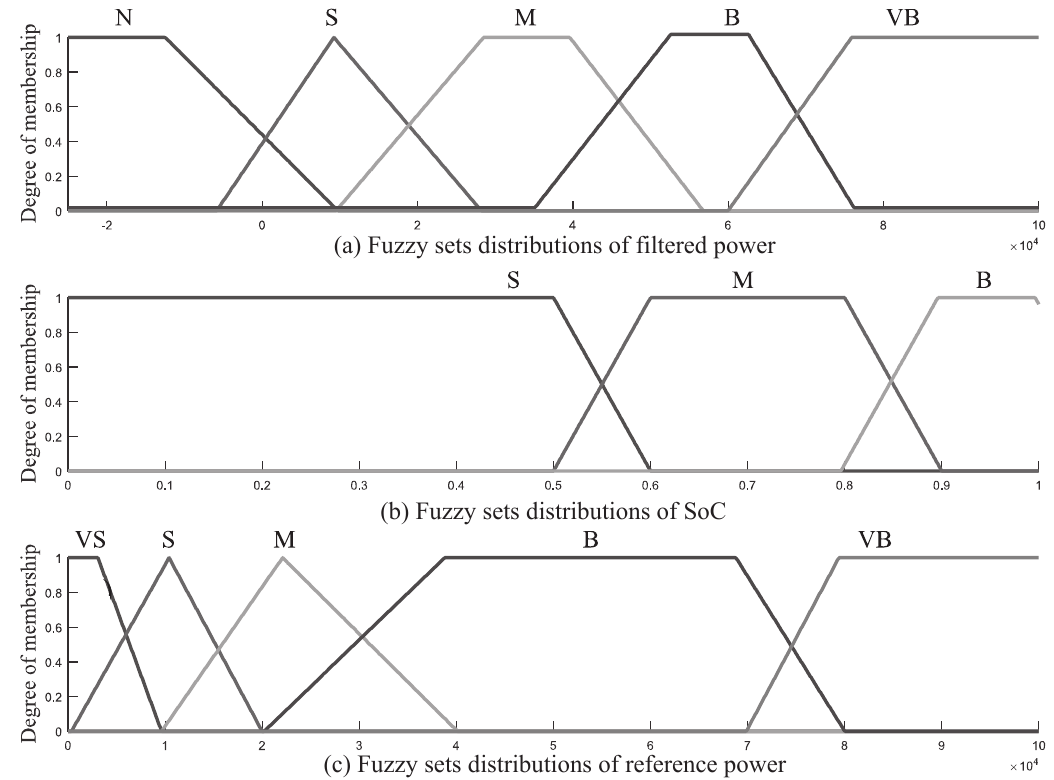
Figure 6. Membership distributions of Fuzzy Inference System (FIS) inputs and output